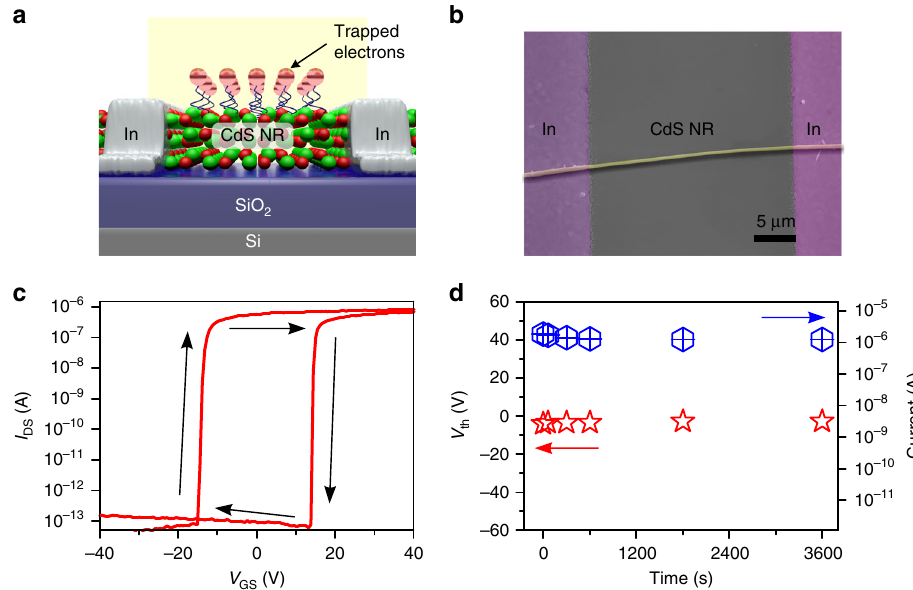
Fig. 1 Phototransistor device with memory function. a Schematic illustration of the CdS NR-based phototransistor device. b SEM image of the phototransistor device. c The electrical transfer characteristic of the CdS NR phototransistor measured in the dark at a fi xed drain voltage of 0.6 V, after it was irradiated with light (190 nW cm − 2 ) for 10 s. Black arrows indicate the scanning directions of the curves. d Threshold voltage and ON current at different retention